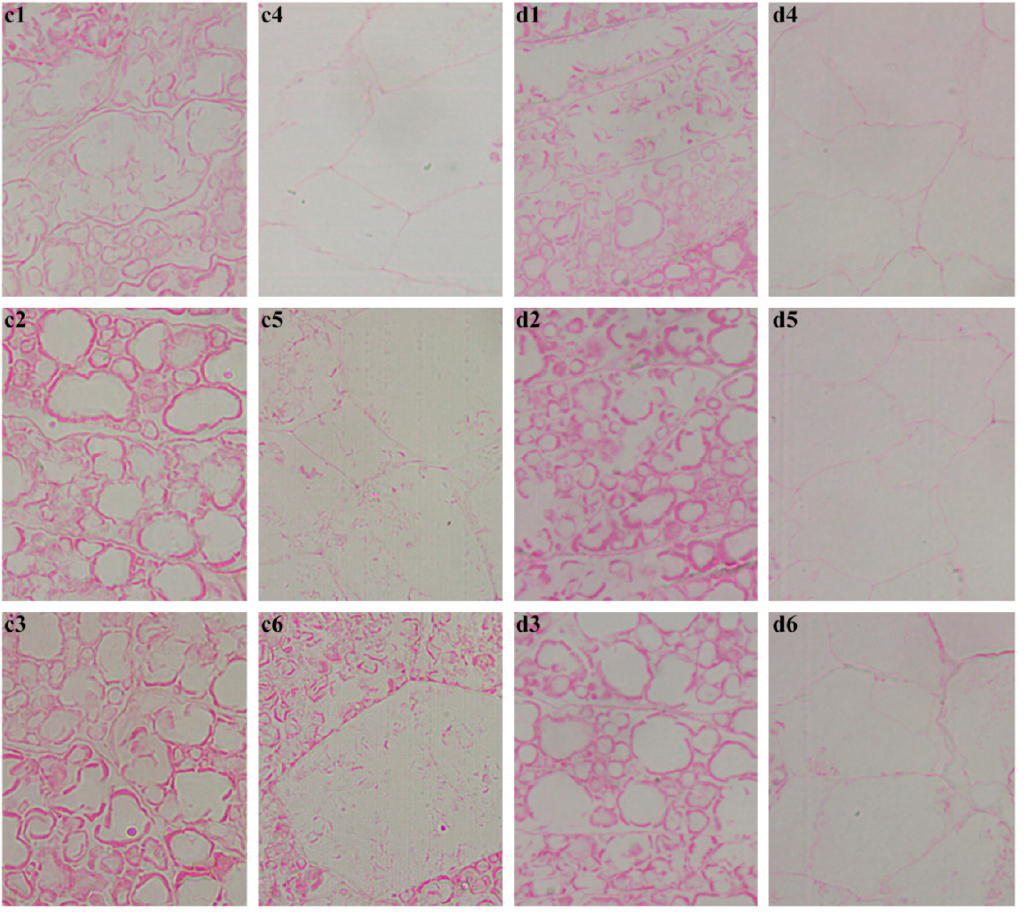
Figure 9. The morphology of the endosperm starch in the GTR seed during seedling growth. ( c ) 12 DAI; ( d ) 16 DAI; (1, 2, 3, 4, 5, 6) the magnification of the square area shown in Figure 6. The section is stained with Schiff ′ s reagent. Scale bar = 20 µm.